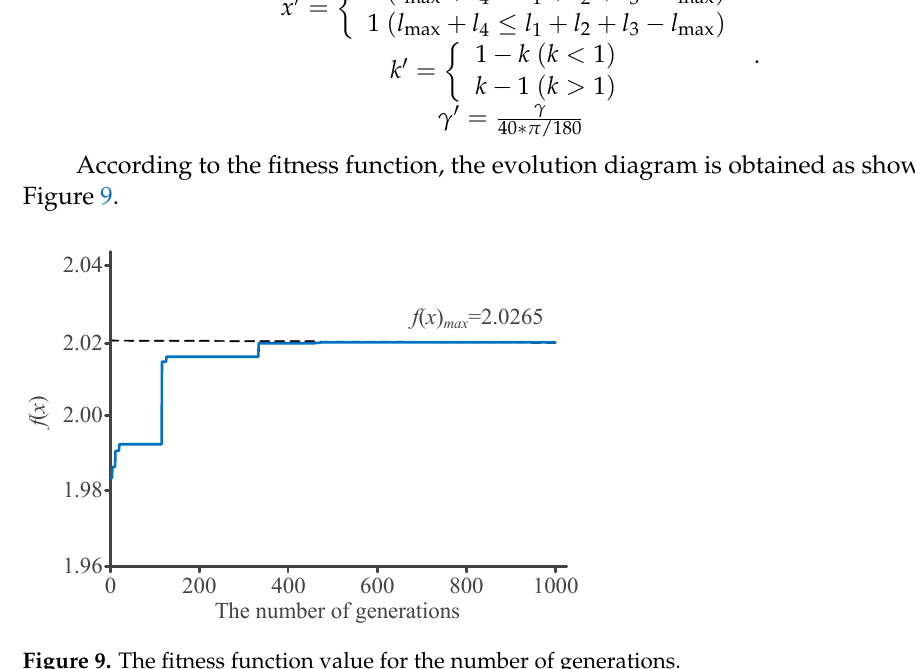
Figure 9. The fitness function value for the number of generations. The number of the evolution generations is 1000, the crossover probability is 0.6, and the mutation probability is 0.01. For the convenience of processing and calculation, all rod lengths should be rounded. The length of the connecting rod l 3 is 56 mm, and the length of the connecting rod l 2 is 44